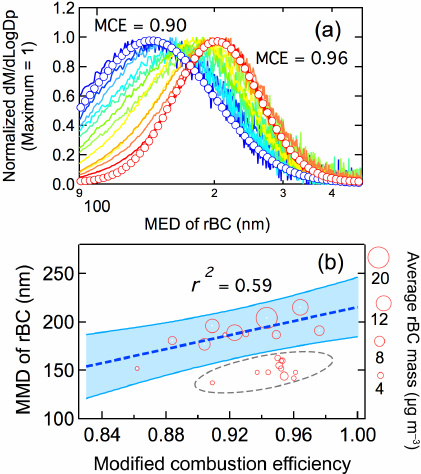
Figure 2. Normalized mass size distribution (maximum value = 1) of rBC particles for each burning experiment (a) . For better under- standing, lognormal curve fittings are shown for a flaming-dominant combustion case (red circle) and a smoldering combustion- dominant case (blue circle). Variation of mode mass equivalent diameter (MMD) as a function of the modified combustion effi- ciency (b) . The size of the circle indicates the average rBC mass concentration for each burning case. Blue dashed line and blue shaded area are the linear fitting and confidence interval for fit coef- ficients. The data in the gray dashed circle are excluded in the linear fitting because of their low rBC mass